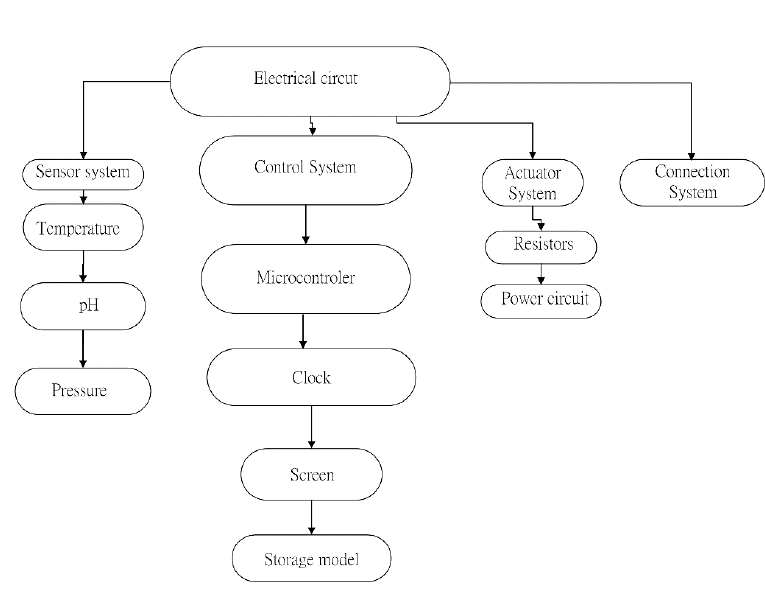
Figure A4. Voltage vs. differential pressure transfer function [9]. •